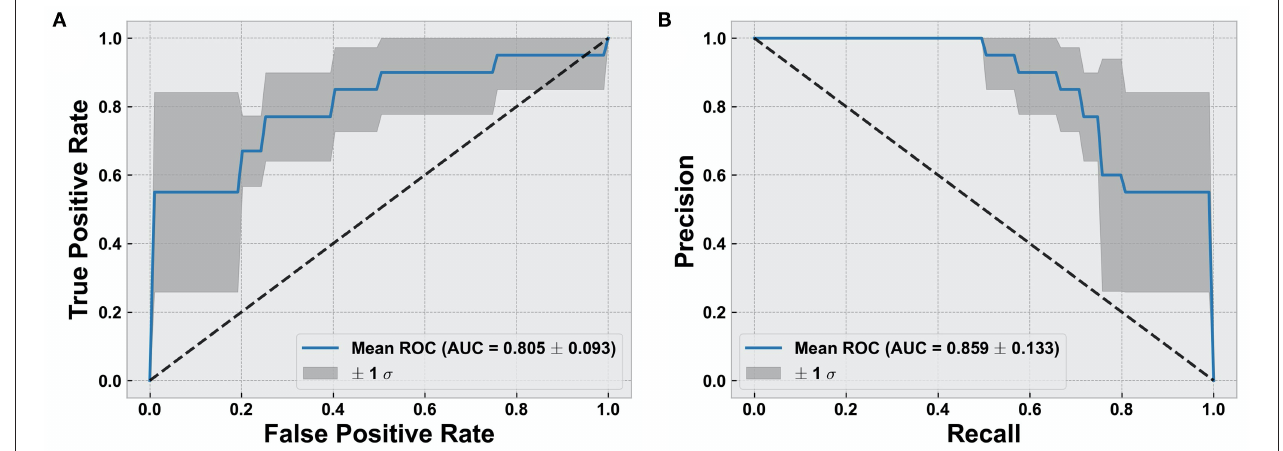
FIGURE 5 | Evaluation of classification results using AdaBoost classifier. (A) Receiver operating characteristic (ROC) curve for cognitively normal compared to cognitively impaired (CI). (B) Precision vs. recall curve (PRC) for cognitively normal compared to CI. Solid line represents the mean curve using five-fold cross-validation. Shaded areas represent ± 1 standard deviation. AUC reported as mean ± standard deviation across five-fold.